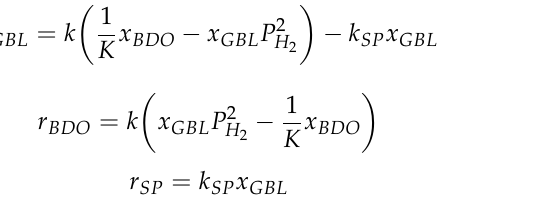
Table 2. Reaction mechanism used for the construction of the second power law model: Model 2. Kinetic or Thermodynamic Reactions Parameters